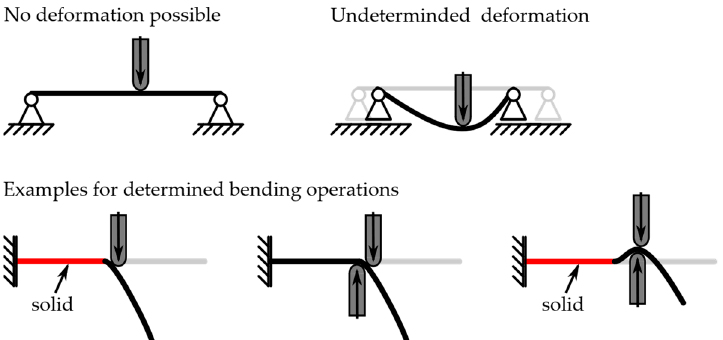
Figure 4. Above: illustration of the problems associated with fixed clamping on both sides or floating support; Below: examples for determined bending operations with one or two forming tools.